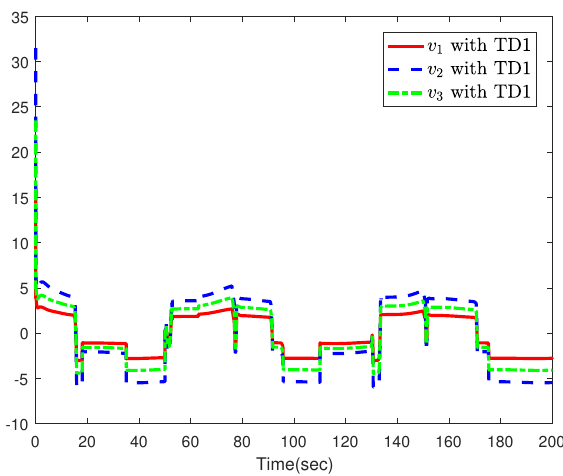
Figure 13. Control effect of System (3) without stochastic noise under TD1.